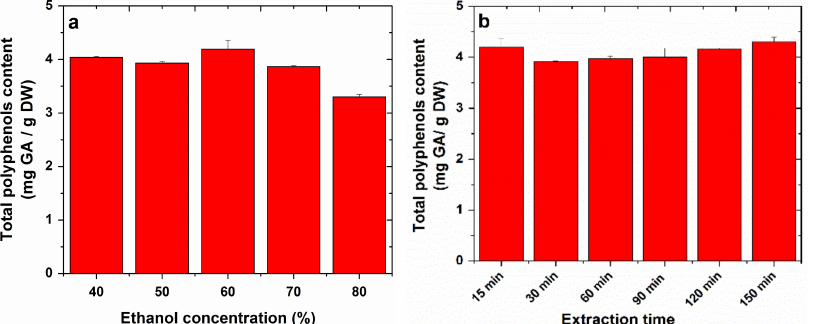
Figure 3. The effect of experimental parameters: ethanol concentration ( a ) and extraction time ( b ), on total phenolic content from apple extracts obtained by refluxing.